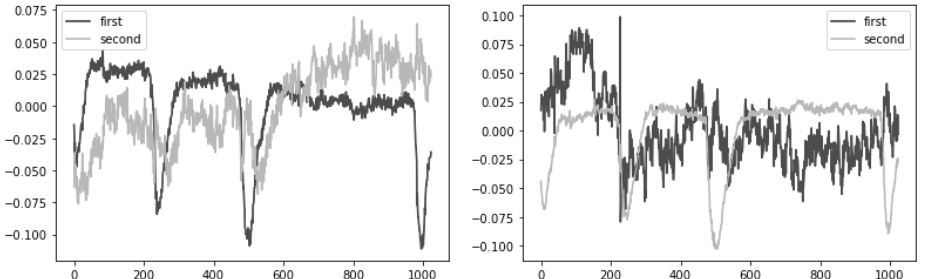
Figure 5. Plots A and B show that the eye noise component is randomly determined sometimes as the first component and sometimes as the second component.